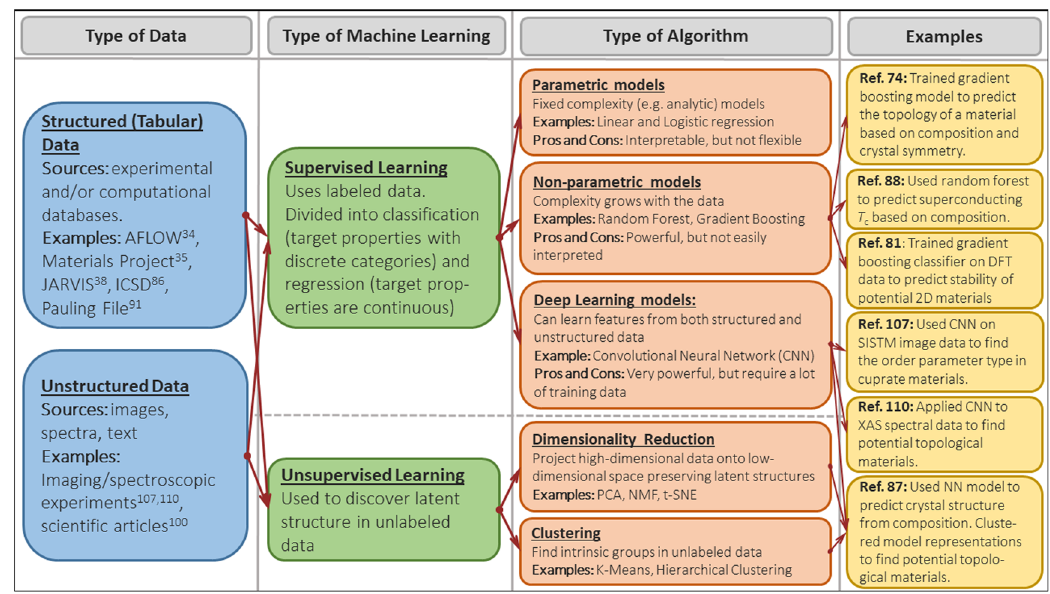
Fig. 1 Commonly used machine-learning tasks and algorithms. The fi gure shows the most common types of machine-learning tasks and algorithms, as well as recent examples of these algorithms applied to quantum materials problems. See Box 1 for the de fi nitions of some key machine-learning